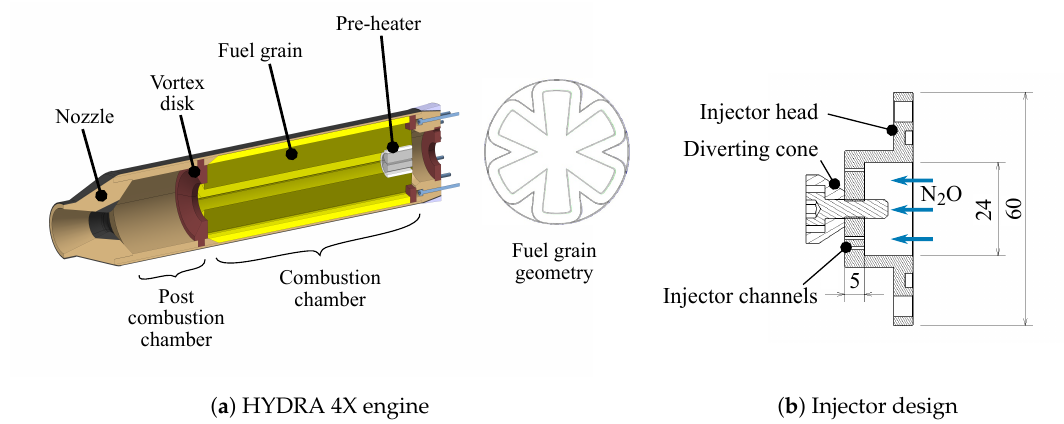
Figure 4. Design of the HYDRA 4X engine and injector with injector channels and the diverting cone. Table 2. Structural and performance characteristics of the engines HYDRA 3X and